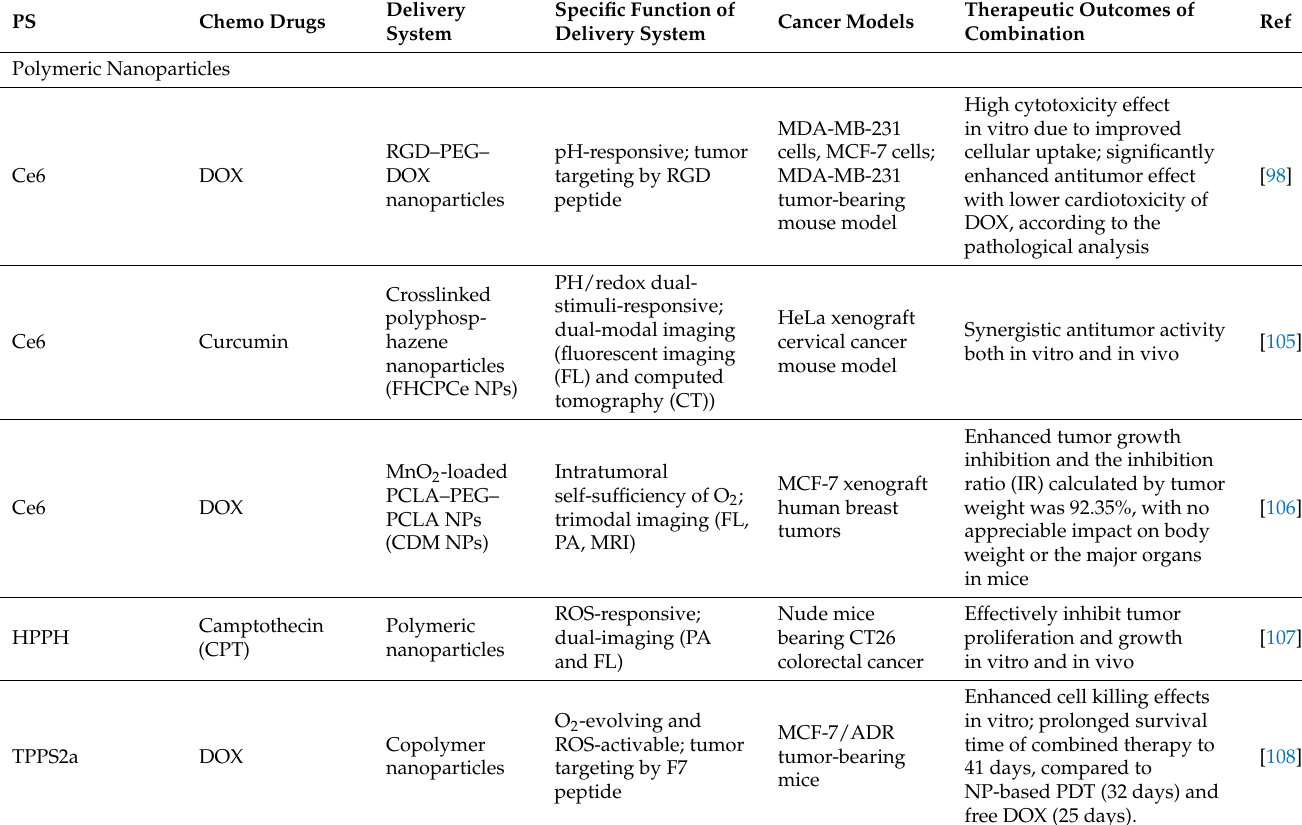
Table 2. Preclinical studies on organic nanoparticles for codelivery in PDT plus